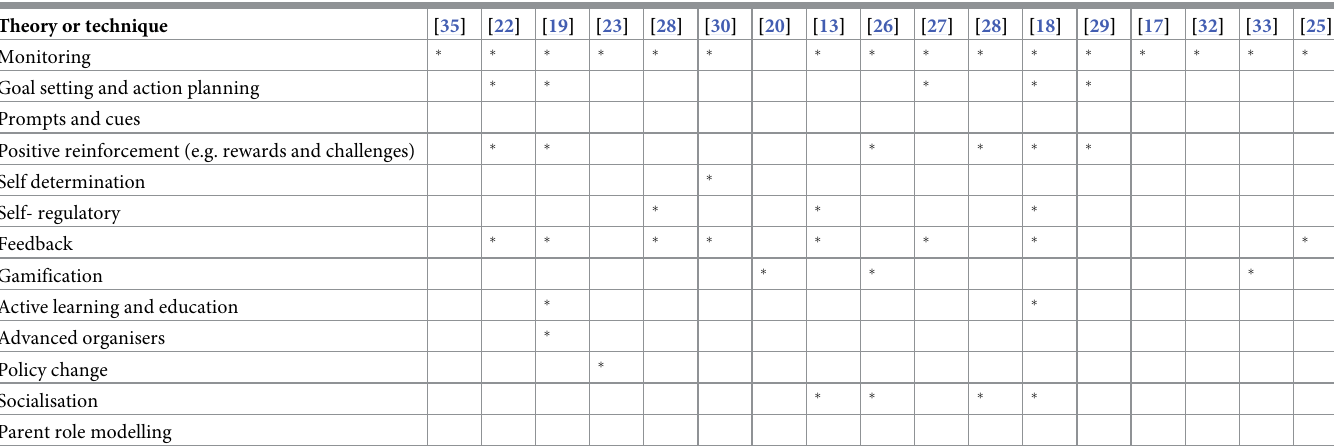
Table 3. Use cases for infants/ children/